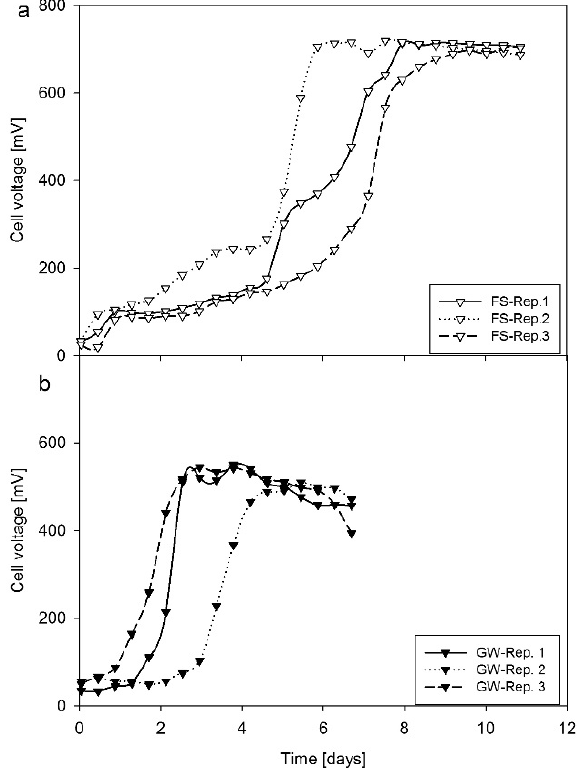
Figure 1. Selection of inoculum for microbial fuel cell (MFC) operation with carbon paper (CP) as electrode material: ( a ) CP-FS: Inoculated with faecal sludge (FS); ( b ) CP-GW: Inoculated with grey water (GW).